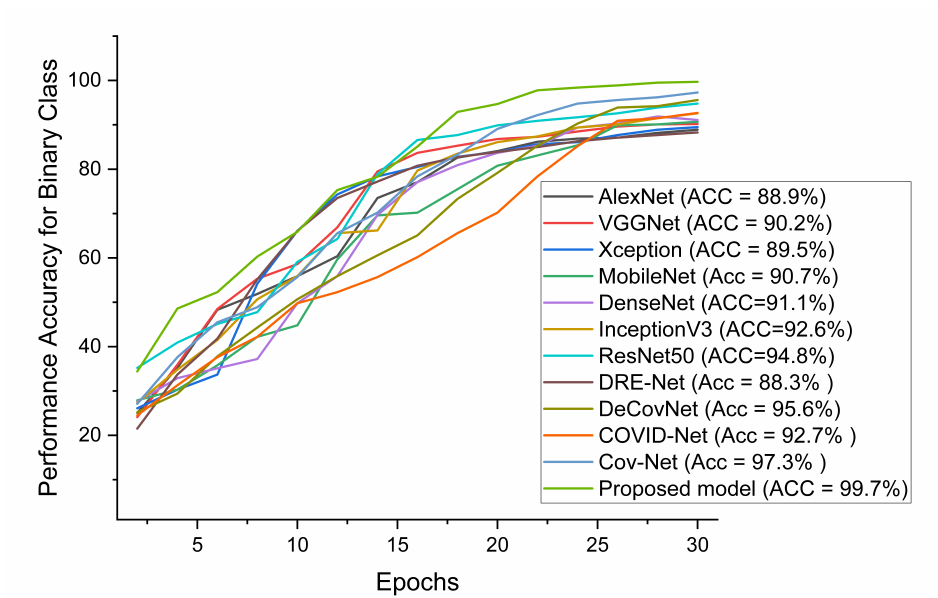
Figure 11. Performance accuracy in comparison with our proposed model and other pre-trained models and selected state-of-the-art COVID-19 models for binary class.